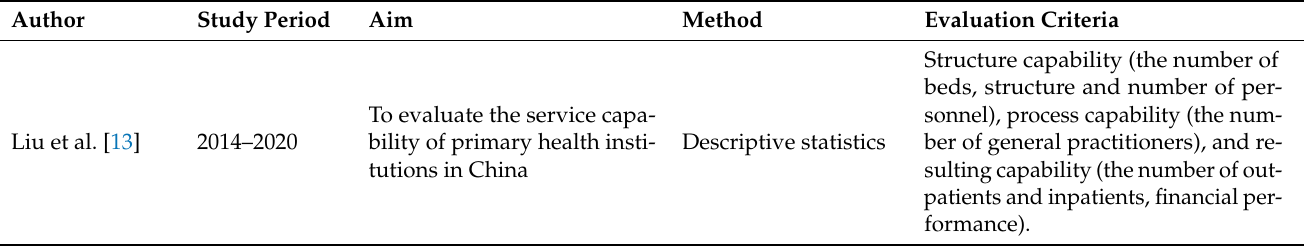
Table A2. Definitions of input, output, and influencing